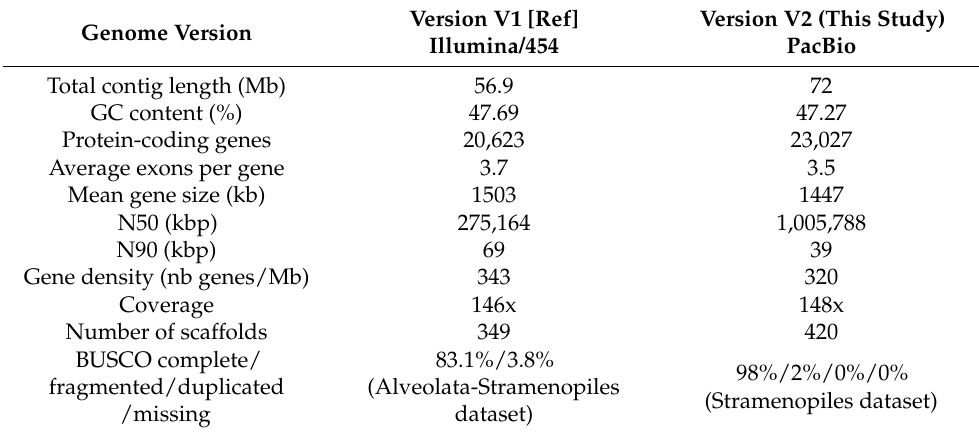
Table 1. Summary of A. euteiches ATCC201684 genome assemblies, annotation statistics and com- pleteness